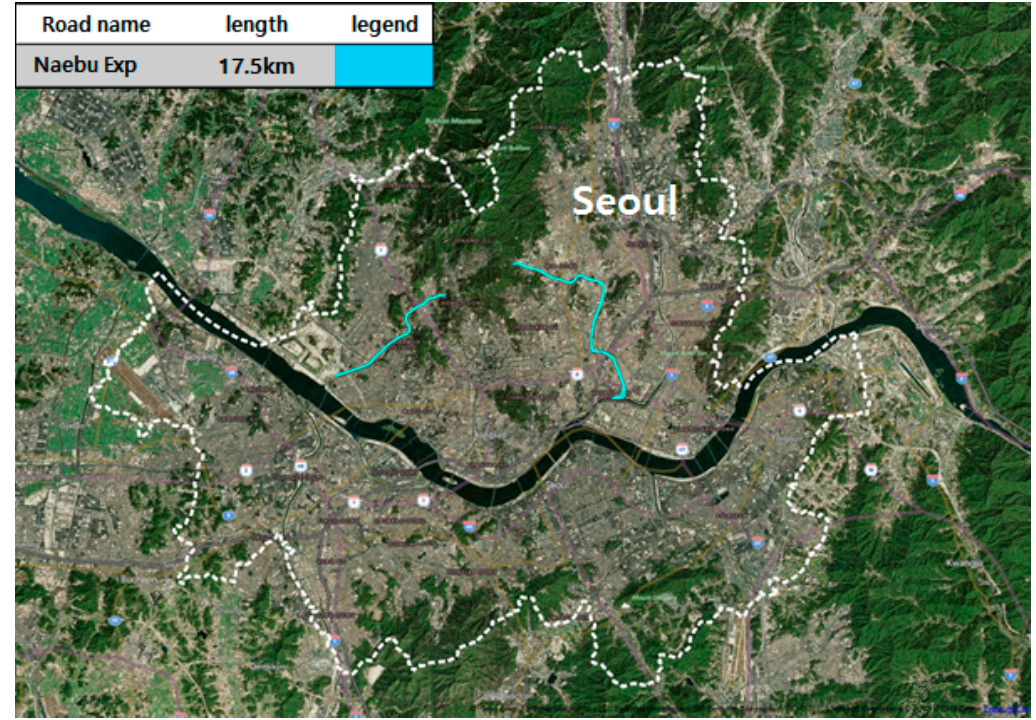
Figure 4. Research site map.